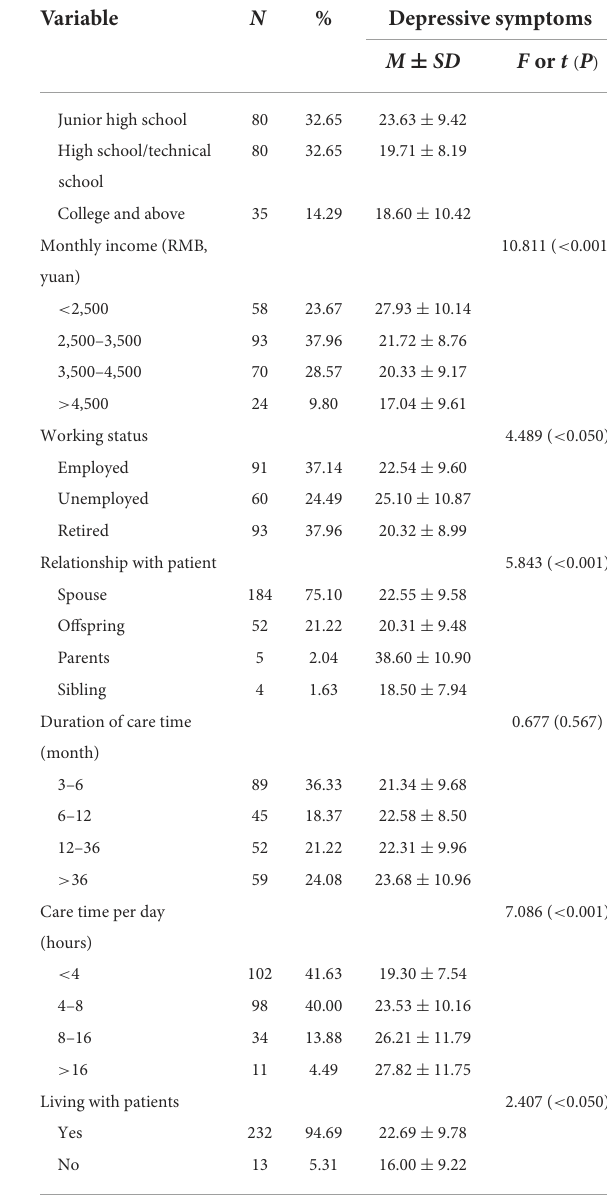
TABLE 1 Descriptive statistics for demographic characteristics and differences in depressive symptoms ( N =